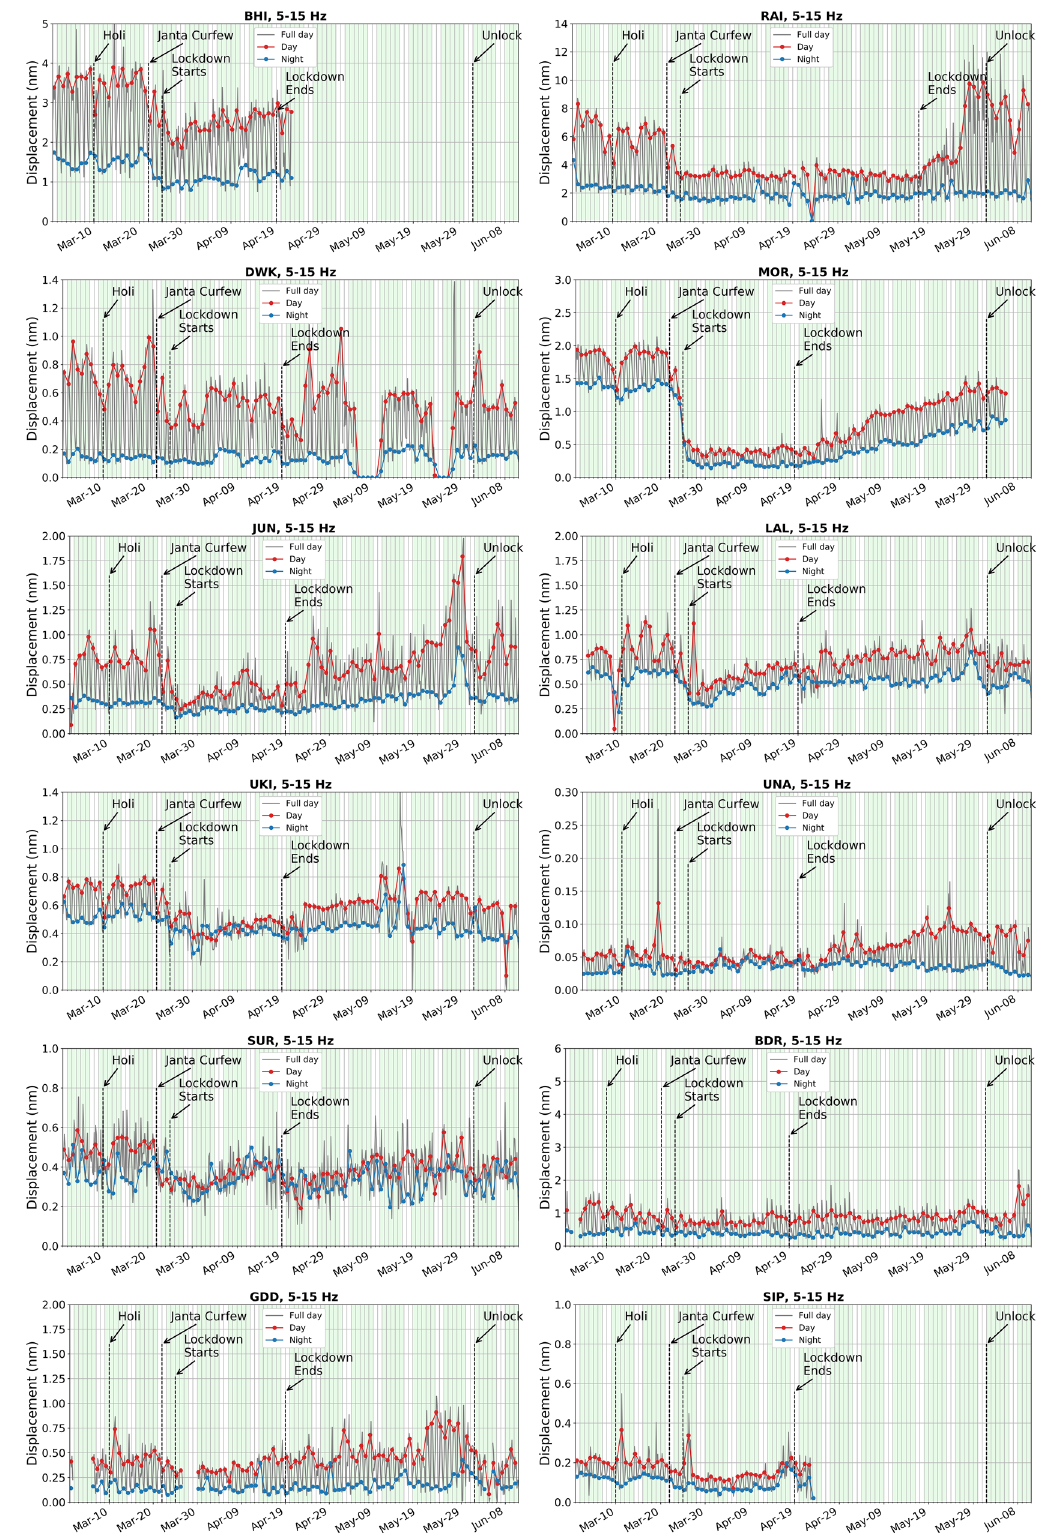
Figure 5. Day wise ground displacement variation in terms of median d rms for the pre-, co- and post-lockdown periods in the frequency range of 5–15 Hz, at all the studied stations. The variation in ground displacement during daytime and nighttime is also shown. The complete lockdown period, beginning of Unlock, Janta Curfew and extended holiday during Holi (Indian Festival) are also marked. For stations BHI and SIP, data is not available after April 22, 2020 due to technical reasons. The lockdown ended on April 19, 2020 at these stations, hence we have considered these stations for analysis. Subsurface geology and other local anthropogenic conditions are mentioned in Table